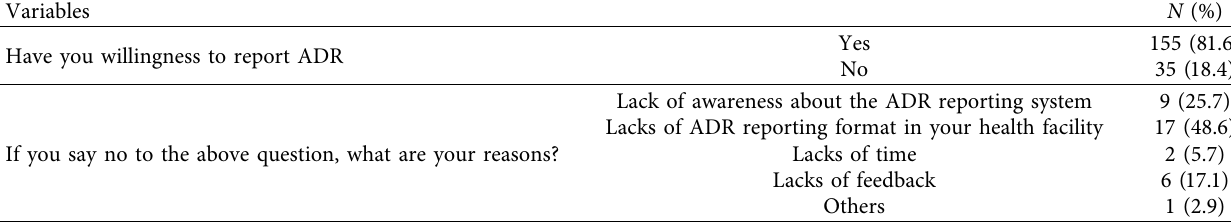
Table 2: Willingness of healthcare providers towards ADR reporting in Mizan Tepi University Teaching Hospital from August to September 2021.